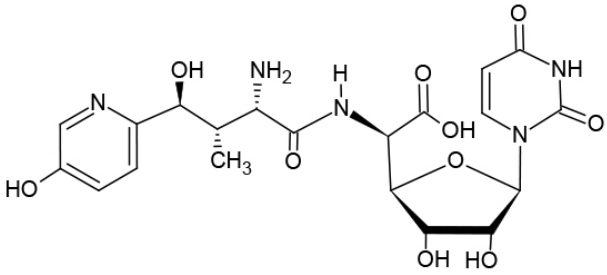
Figure 1. Nikkomycin Z (HCl). C20H25N5O10-HCl.